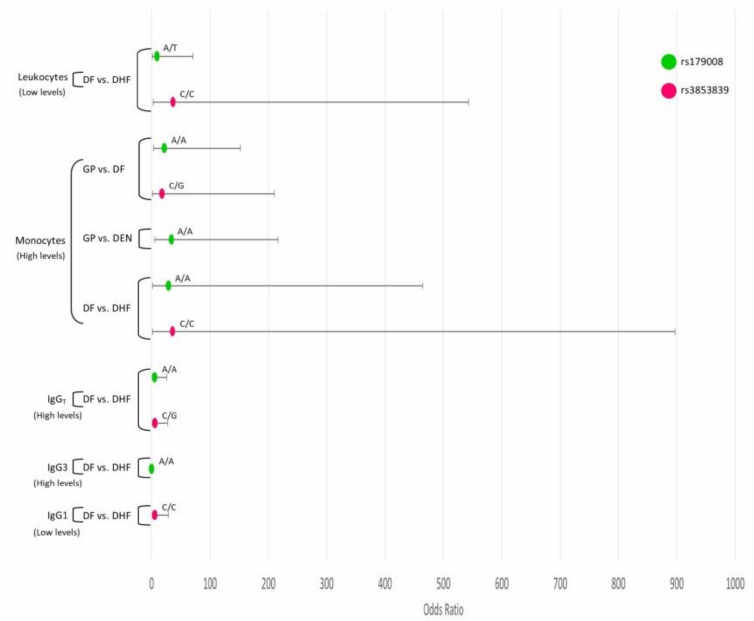
Figure 3. Interaction analysis of TLR 7 SNPs and the hematological covariates. Interaction analysis of TLR7 SNPs and the levels of hematological covariates leukocytes, lymphocytes, monocytes, and immunoglobulin levels of total IgG, IgG1, IgG3. Odds ratios and confidence intervals are shown in abscissa axis and genotypes are indicated above the odds ratios